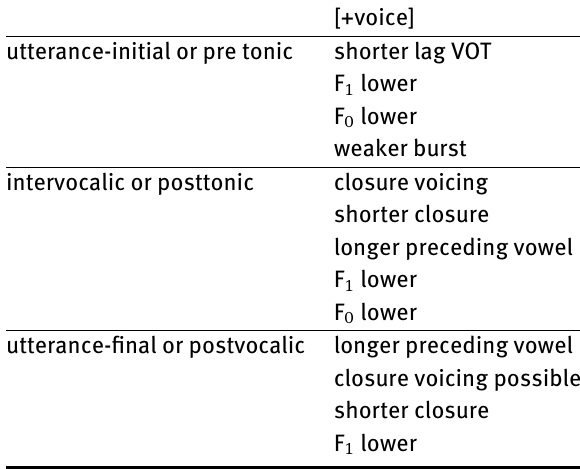
Table 1: Variable phonetic realizations of English [+voice] obstruents. Adapted from Kingston and Diehl (1994: